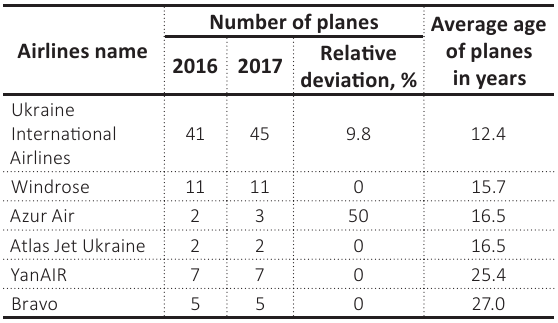
Table 4. Technical characteristics of the fleet of top 5 charter airlines